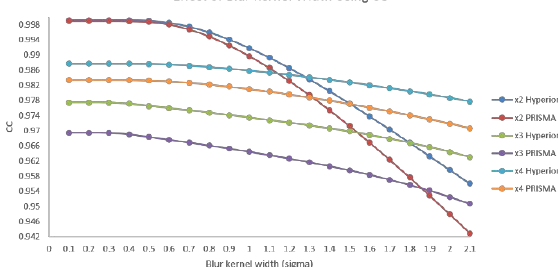
Figure 7. Effect of Blur Kernel Width Using E on IBP’s Performance E values for both PRISMA and Hyperion show a similar pattern except the values being lower in case of Hyperion due to more number of bands (128) than the PRISMA data (112). Again σ = 0.1 shows the highest E for each SF irrespective of the dataset.